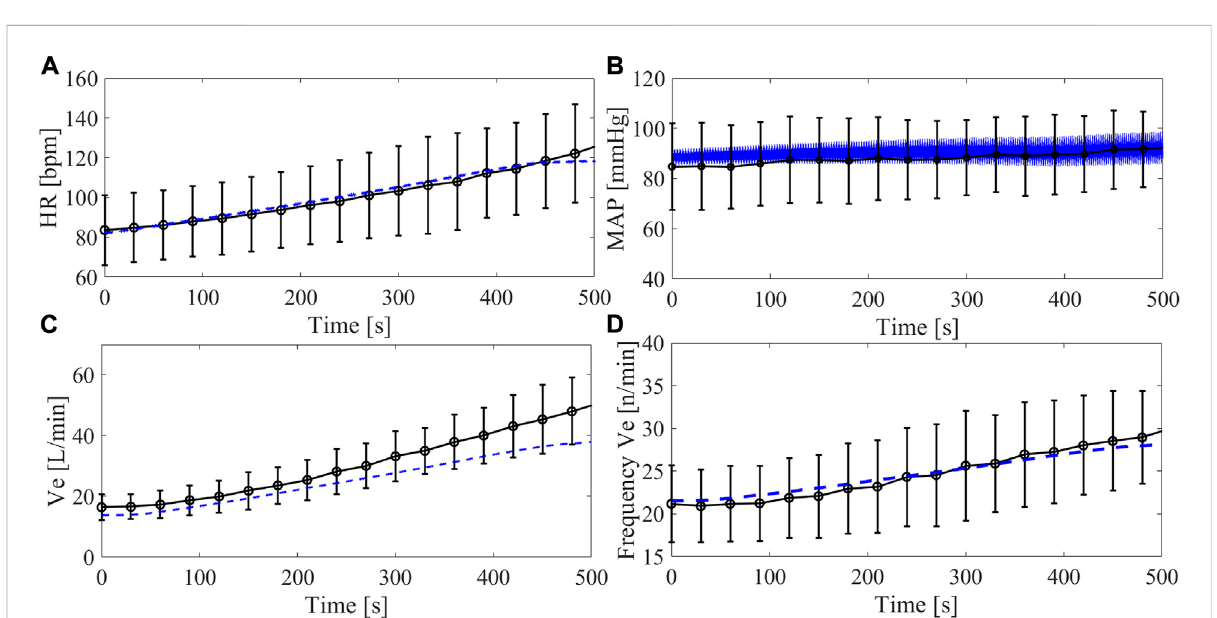
FIGURE 7 Trendofcardiorespiratory parametersovertime duringtheGroup2exercisetest(from 10to90 W): heartrate (A) , arterialsystemicpressure (B) , ventilation (C) ,ventilationfrequency (D) .BlacklinesrefertoclinicaldatafromGroup2(averageandstandarddeviation),bluelinesrefertosimulations data. For the arterial systemic pressure, average values are shown for the clinical data and waveforms are reported for the